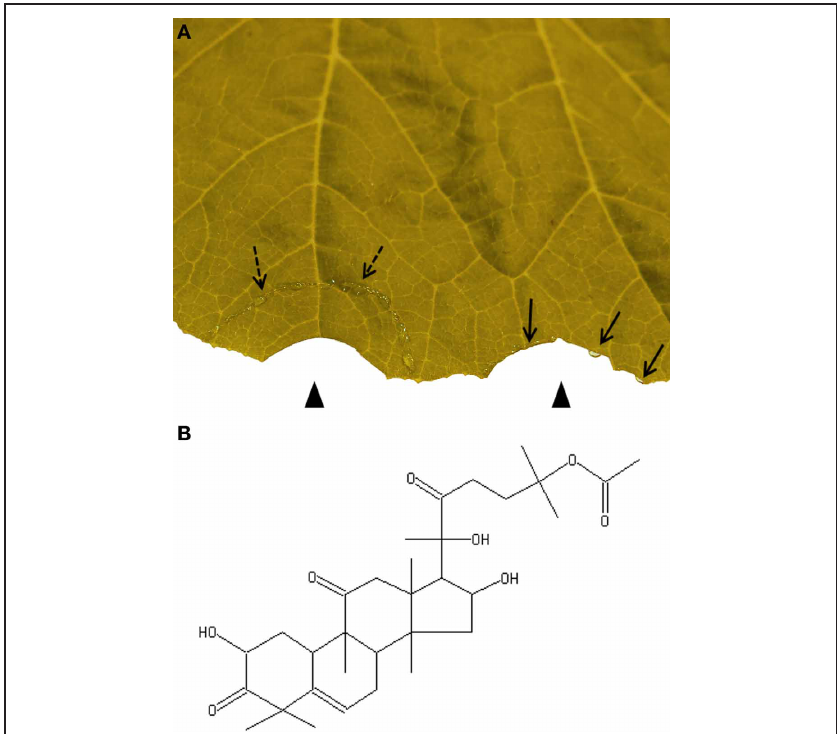
FIGURE 1 | Trenching is a strategy of herbivorous insects for avoiding ingestion of toxic phloem latex. (A) Artificial trenching releases phloem latex (broken arrows). The isolated semi-circular area is cleared from phloem latex as demonstrated by a cut from which no exudate emerges (left arrow head). In contrast droplets of exudates (arrows) appear from a cut outside of the trenched area (right arrow head). (B) Cucurbitacin B is present in most